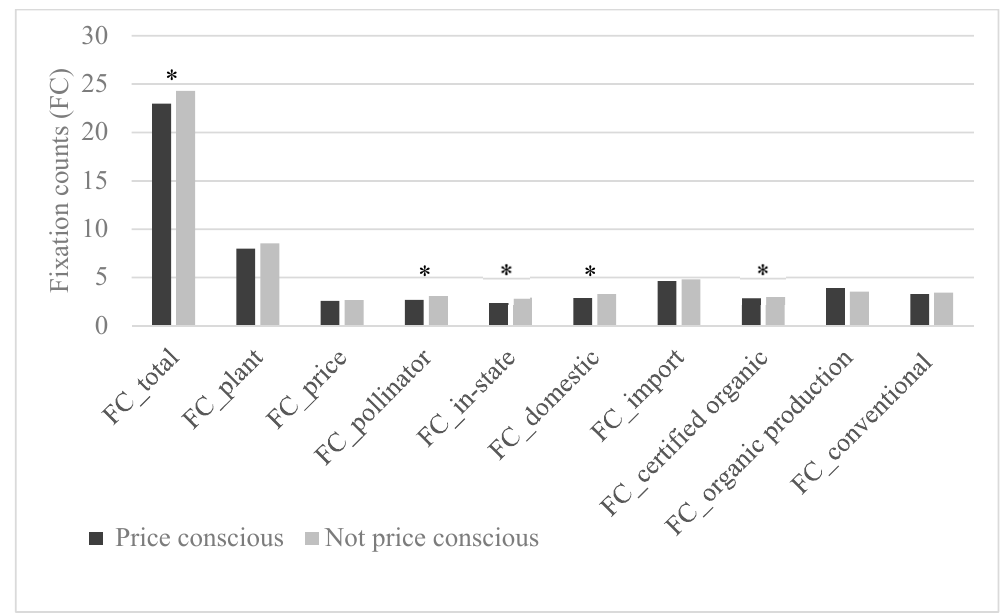
Figure 5. Mean Fixation Counts, by Price Consciousness. * indicates the mean difference between price conscious and non-price-conscious consumers is significant ( p < 0.05) based on pairwise t -test.